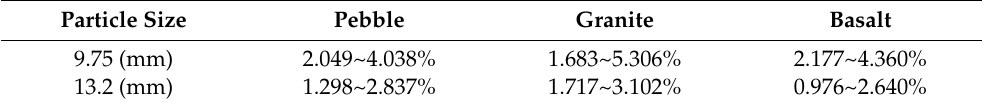
Table 4. Parameter range of surface area change rate.